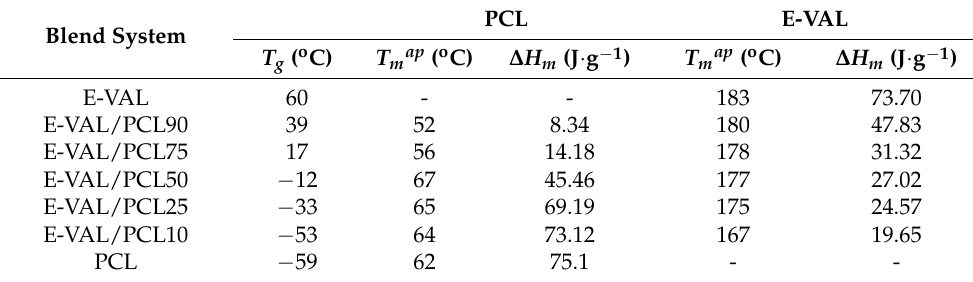
Figure 1. SEM micrographs of surface morphologies of E-VAL/PCL blends and their pure poly- mer components. Table 2. Comparative data of the E-VAL/PCL blend with different compositions, obtained by